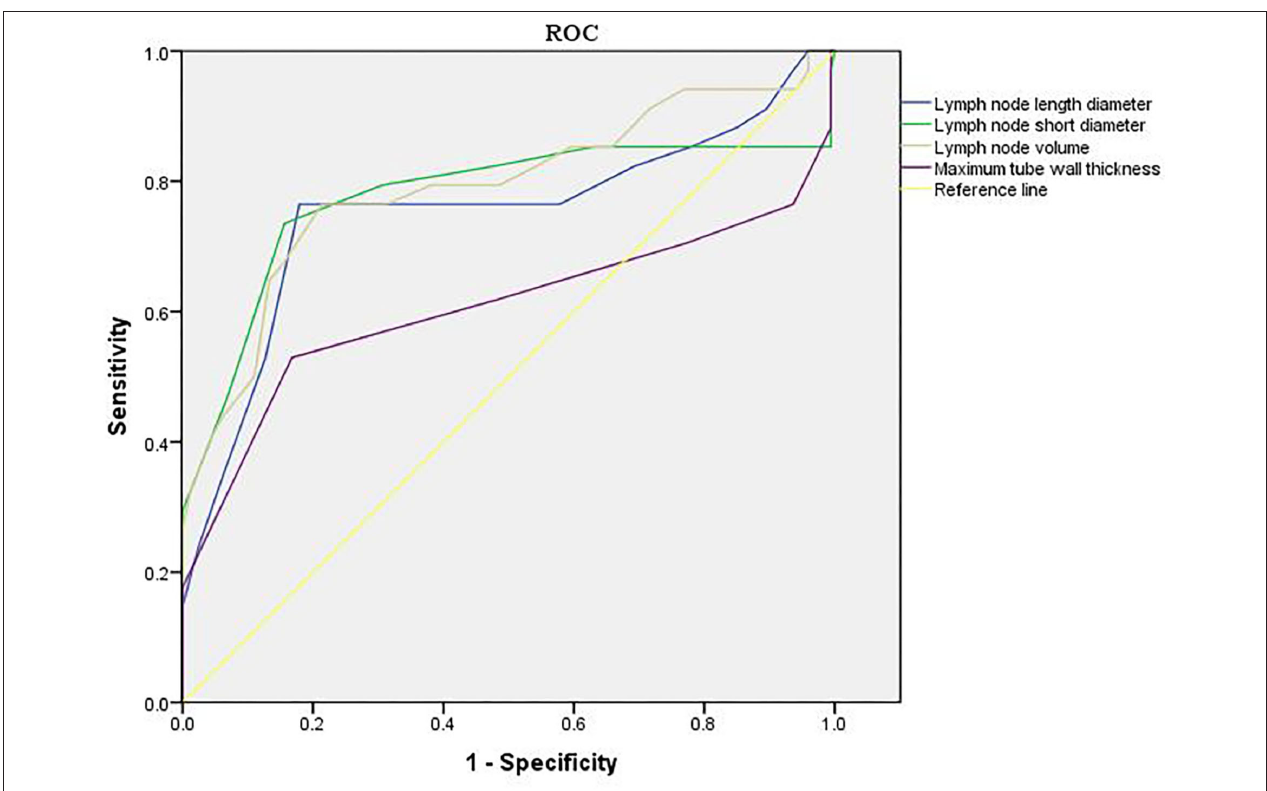
FIGURE 5 | Value of imaging results in evaluating